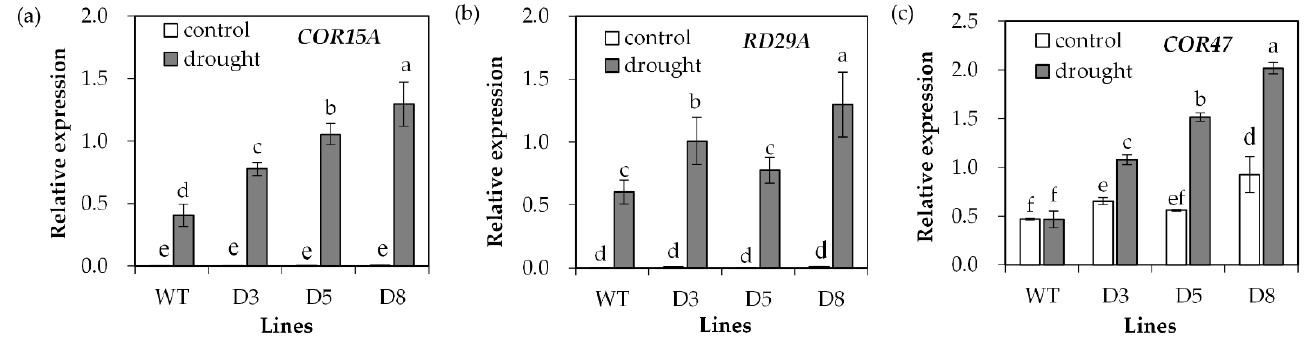
Figure 7. Analysis of antioxidant enzyme activities in transgenic plants in comparison with the wild type (WT). Three-week old seedlings were withheld from irrigation for 14 days (drought) or contin- uously irrigated as control, and leaves were sampled for measurements of SOD ( a ), CAT ( b ) and APX ( c ) activities. Means of three replicates and standard errors are presented; the same letter above the column indicates no significant difference at p < 0.05.